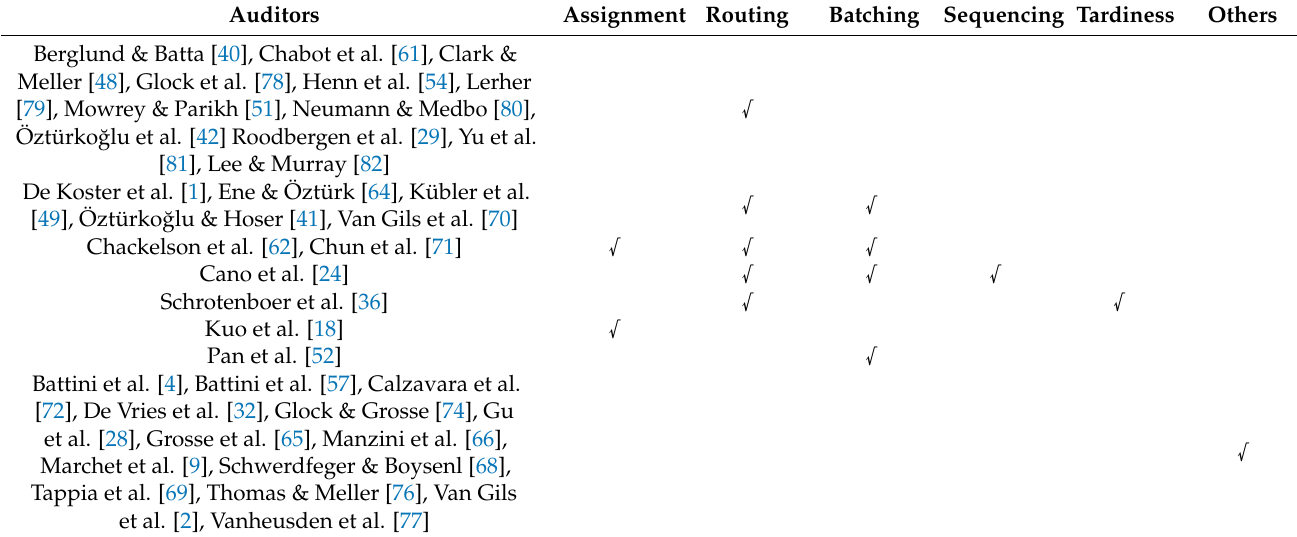
Table 8. Overview of the reviewed articles on Space optimization.